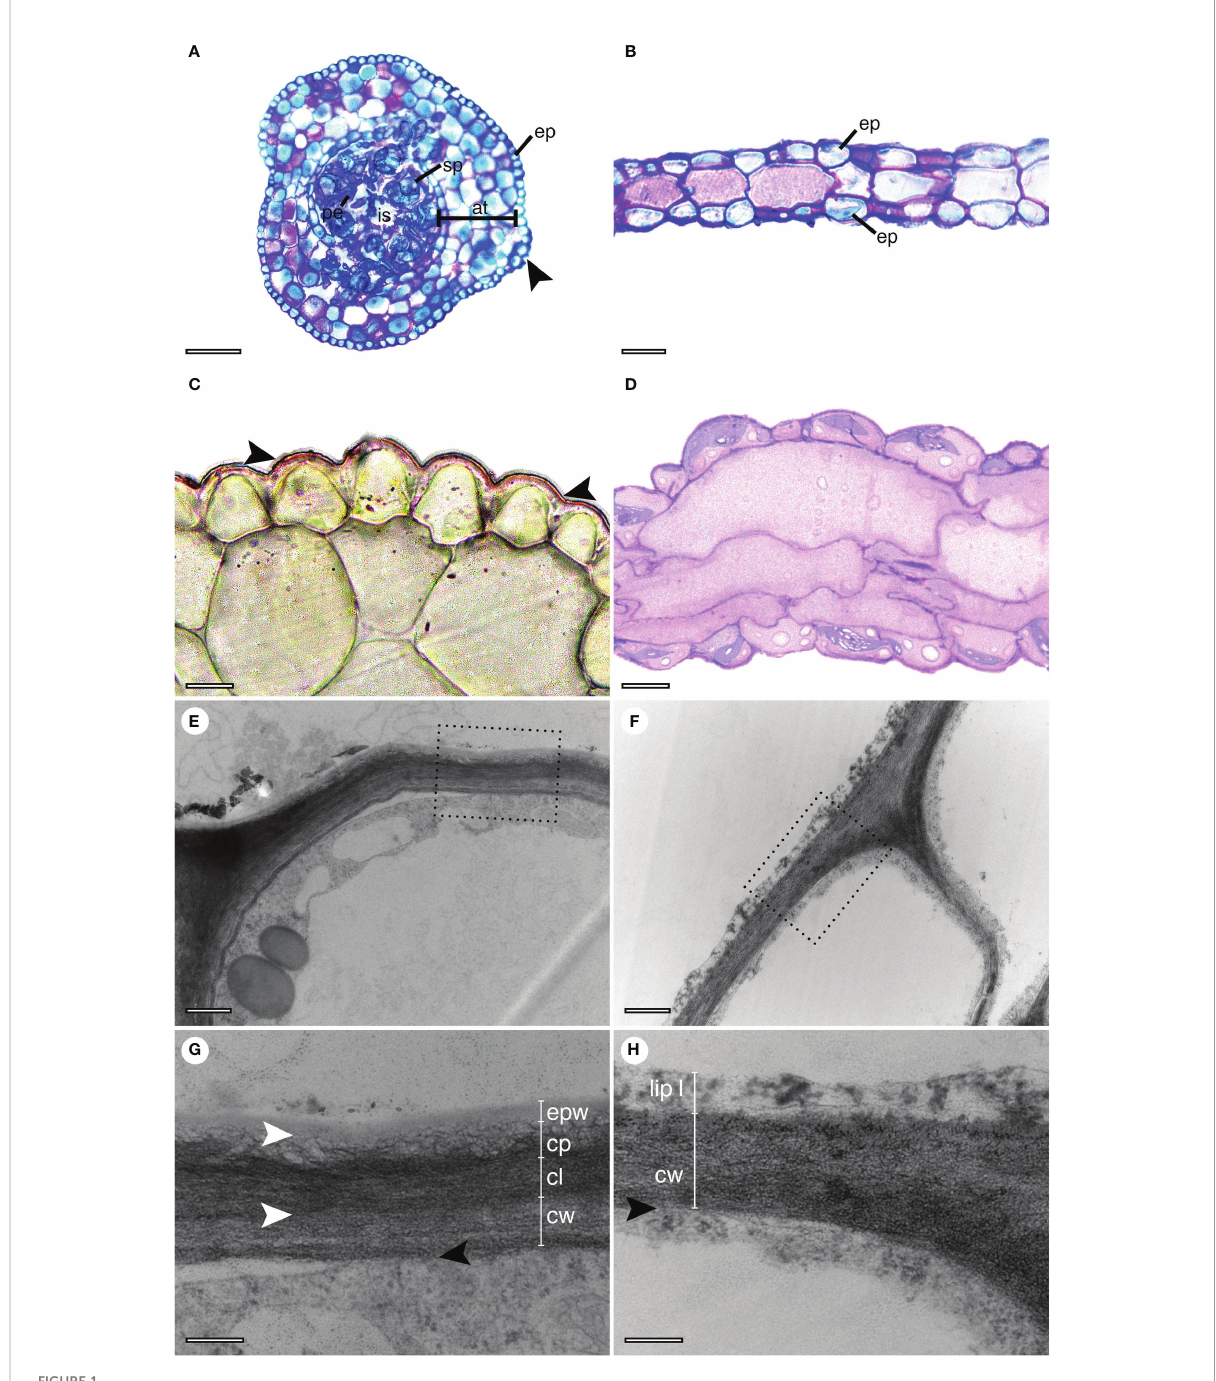
FIGURE 1 Cross-sections of Phaeoceros laevis . Images in the left column are sporophytes and in the right side are gametophytes. (A – D) Semithin sections observed under a light microscope. (A) Sporophyte stained with toluidine blue, with the mature capsule containing spores (sp) and pseudoelaters (pe) surround an inner space in the center. Layers of assimilative tissue (at) surround the sporogenous tissue. The entire structure is surrounded by an epidermis (ep) with a stoma (arrow). (B) Gametophyte stained with toluidine blue, covered by a epidermis (ep). (C) Thin cuticular layer (indicated by arrows) stained with Sudan IV on the sporophyte surface. (D) Detail of the gametophyte, stained with Sudan IV. (E – H) TEM. The squares in (E, F) are magni fi ed in (G, H) , respectively. (E) The outer surface of an epidermal cell in the sporophyte. (F) The outer surface of two epidermal cells in the gametophyte. (G) The cell wall (cw) of the sporophyte is covered by a strati fi ed cuticle. Cuticular layer (cl), cuticle proper (cp), and epicuticular waxes (epw) are indicated. (H) The cell wall (cw) of the gametophyte is covered by a lipidic layer (lip l). Bars: (A, B) : 100 µm, (C, D) : 10 µm, (E, F) : 0.5 µm, (G, H) : 0.2